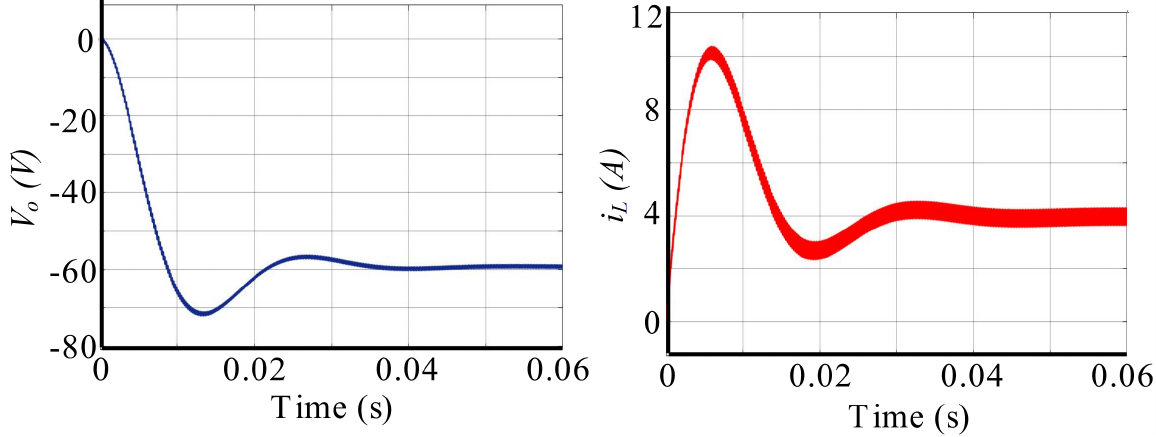
Figure 9. Graph of the S 1 parameter set ICCV in continuous time through (20)–(23) and knowledge of the ICCV at the beginning of each switching period.